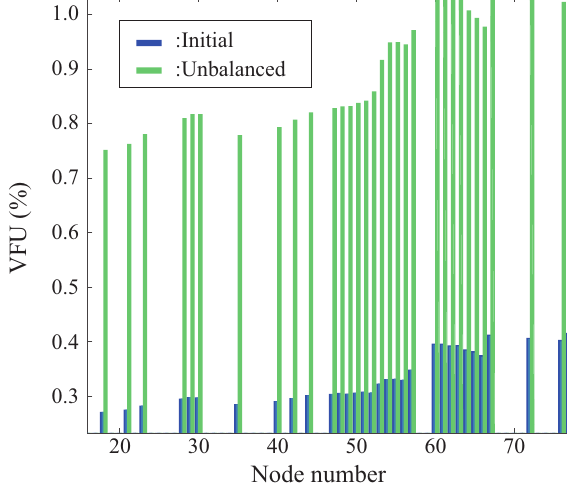
Figure 17. Load unbalanced condition (load of phase a increased by 20%).